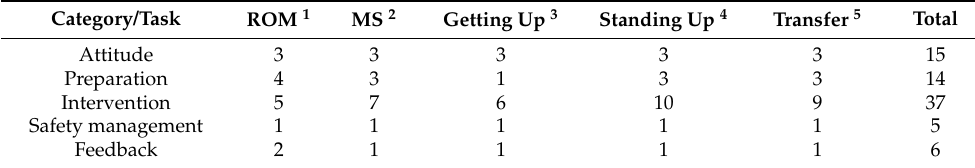
Table 1. Number of items according to each task and category. Category/Task ROM 1 MS 2 Getting Up